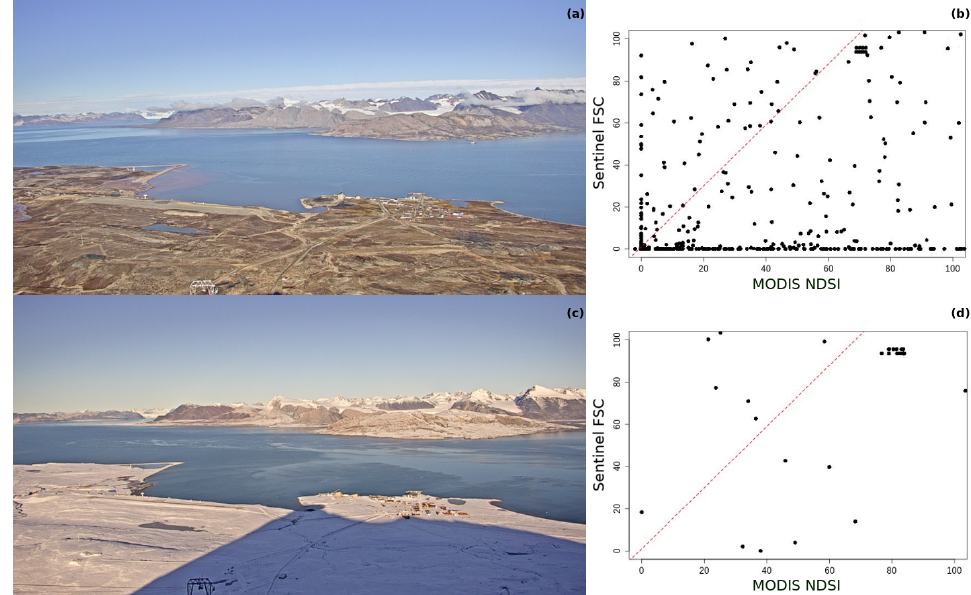
Figure 22. The snow cover at Ny-Ålesund during two different seasons: (a) 20 August 2018 and (c) 17 September 2018. (b, d) Relationship between the spectral index of snow (NDSI) obtained by MODIS data and the fractional snow cover estimated by Sentinel-2 and detected by terrestrial photography (Pedersen, 2013).